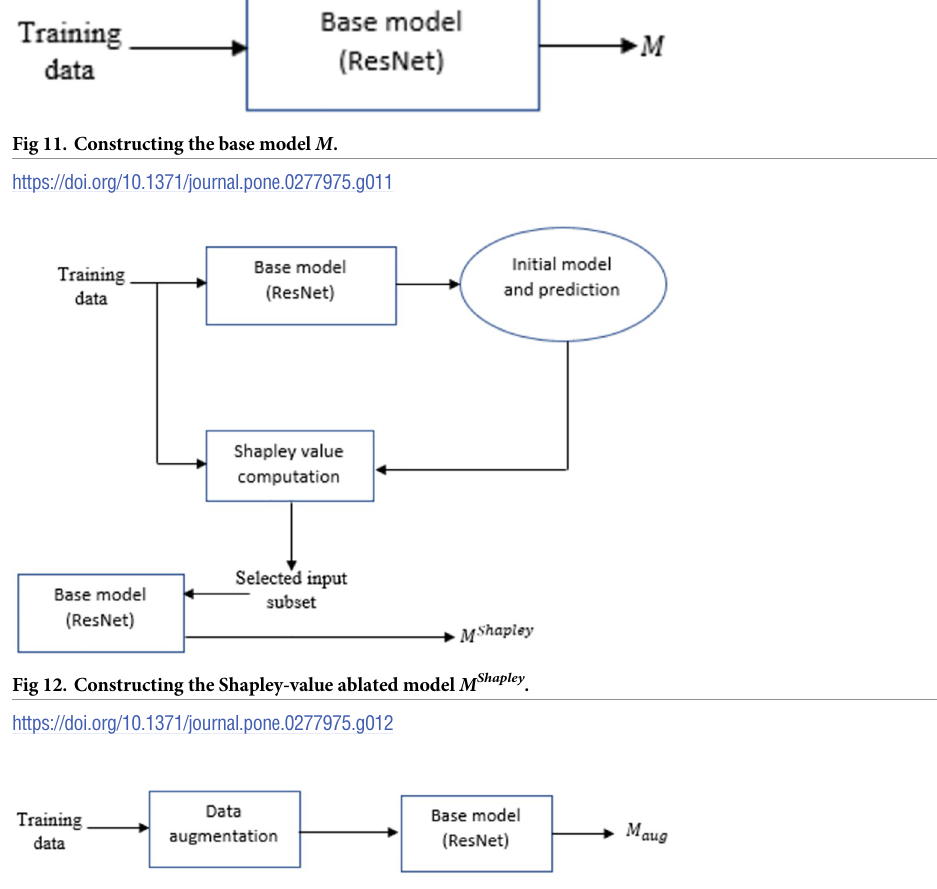
Fig 13. Constructing the augmented learning model M aug